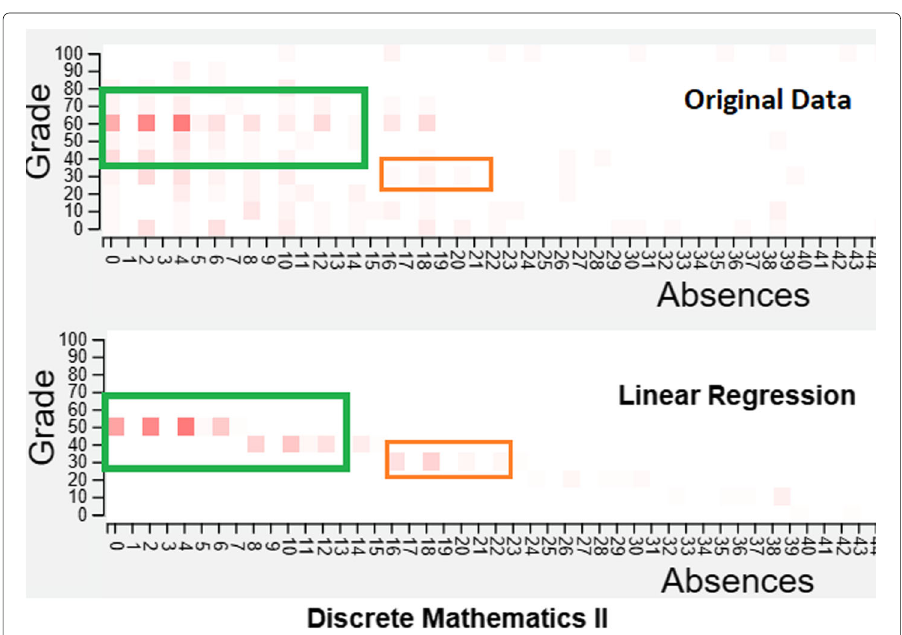
Fig. 14 Discrete Mathematics II: Original data vs. Linear Regression prediction